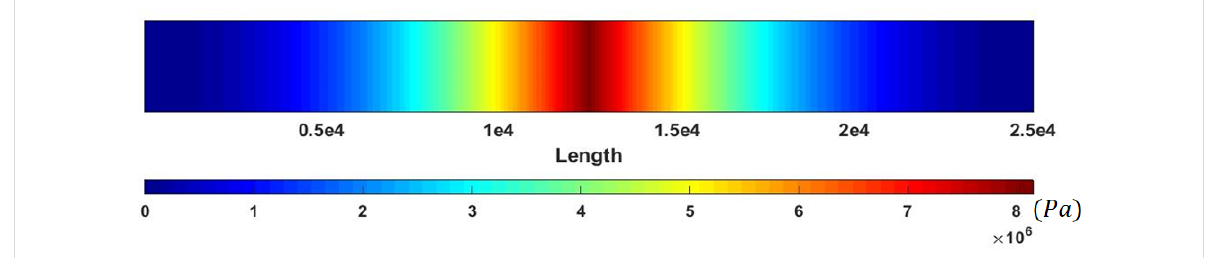
Figure 15: Equivalent stresses (nonclassical) in a cylindrical gold nanoparticle with a length of 25 µm and aspect ratio of 30.